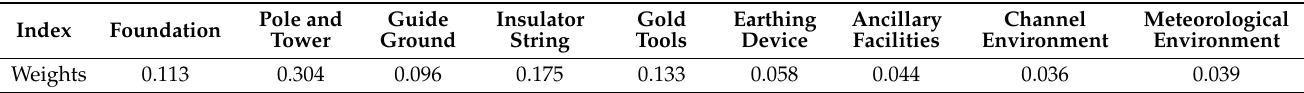
Table 7. Criteria layer indicator weights.